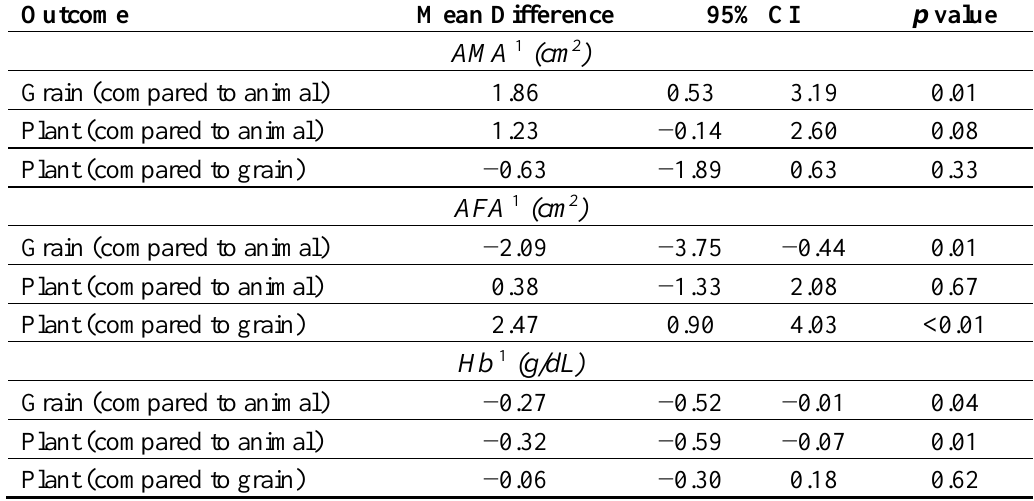
Table 3. Predicted mean difference in arm muscle area (AMA), arm fat area (AFA), and hemoglobin level (Hb) of women in the three clusters of dietary patterns. Outcome Mean Difference 95% CI Grain (compared to animal) Plant (compared to